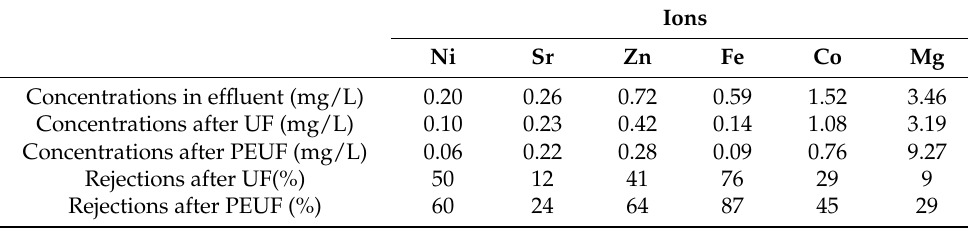
Table 5. Concentration of some elements before and after the UF process (with and without the chitosan). Adapted with permission from ref. [40]. Copyright 2021 Elsevier.